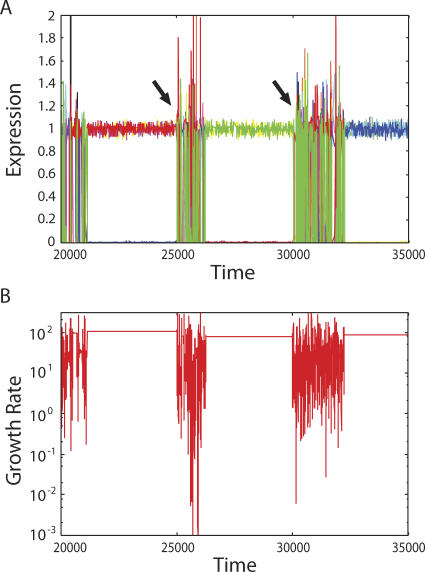
Adaptation Process over Several Environmental Conditions(A) Time series of protein expressions xi(t) when the environmental condition is altered. The environmental conditions, i.e., substrates having nonzero Yi, are changed at time points indicated by arrows.(B) Change of growth rate vg in the same time interval as (A). After the environmental changes, both expression levels of all proteins and the growth rate start to fluctuate until the cell finds a state of protein expression that realizes a high growth rate. In the simulation, the noise amplitude σ = 0.2.